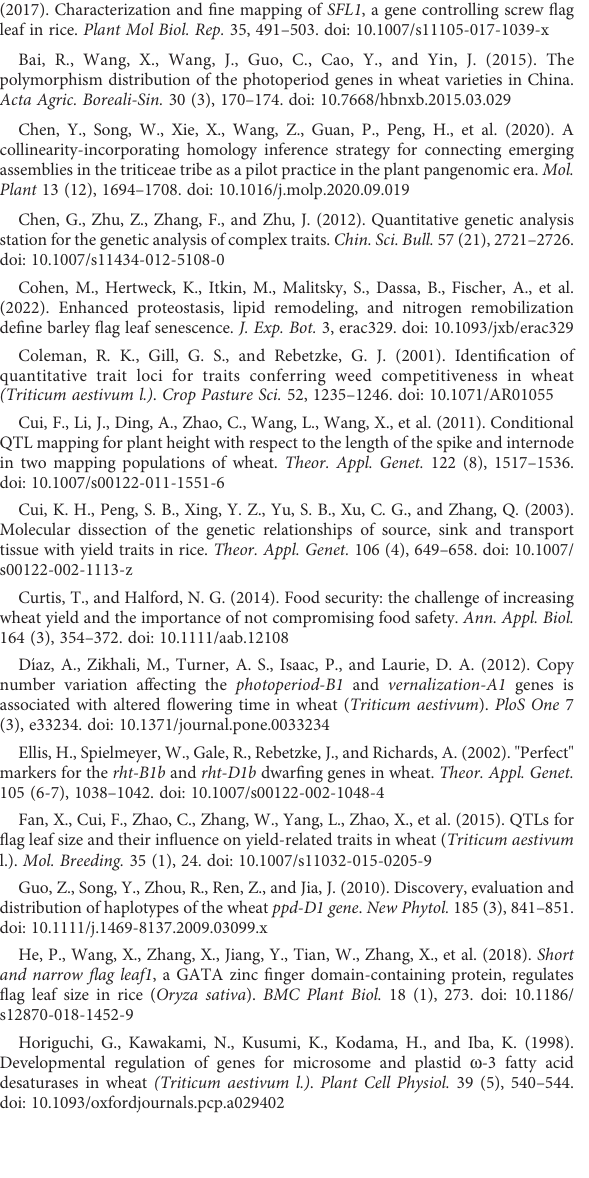
on FLL, FLW, and FLA, respectively. + and − represent lines with and without the positive alleles of the target QTL based on the fl anking markers of the corresponding QTL, respectively. **** represents signi fi cant at P < 0.001 SUPPLEMENTARY FIGURE 4 Expression pattern of genes within the QFll/Fla.cib-2B interval. (A – D) represent leaf, grain, spike, and root by Triticeae Multi-omics Center, respectively; (E – H) represent leaves/shoots, grain, spike, and roots by Wheat Expression Browser, respectively. SUPPLEMENTARY FIGURE 5 QTL analysis (A) , genetic map (B) , and physical map (C) of QFlw.cib-4B.3